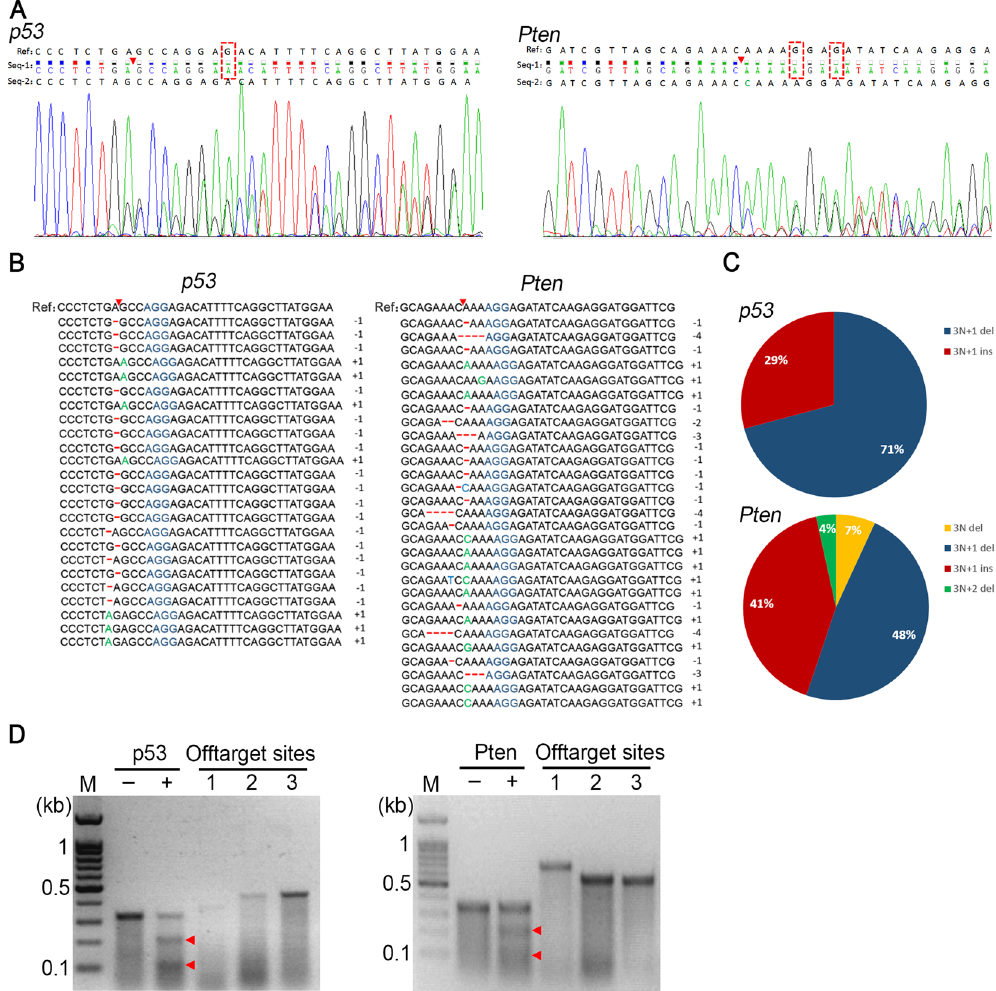
Figure 5. Mutational analysis of individual tumors of C57-HBV mice injected with dual sgRNA cassette. ( A ) Representative p53 and Pten mutations found in the predicted cut sites in tumors. The reference sequences were mouse genomic sequences from the National Center for Biotechnology Information (NCBI; p53 , genebank ID:372099099; Pten , genebank ID:372099091). Seq-1 and Seq-2 represent read sequences obtained from sequencing chromatograms. Different bases between Ref and Seq-1 were revealed with red dashed rectangles. Red triangles indicate the predicted cleavage sites. ( B ) Sequence analysis near the predicted cleavage sites of p53 and Pten in the tumors. A total of forty tumor nodules were examined and only the mutant sequences of p53 or Pten were shown. Red triangles, predicted cleavage sites; Blue bases, the PAM motif; Red lines, deletion; Green bases, insertion; Bases in light blue, mutation. ( C ) Indel mutation profile of p53 and Pten in the tumors. Distribution of indel frame phase was calculated as the length of modulus 3. ( D ) Off-target assessment using the T7E1 nuclease. The p53 and Pten top ranking off-target sites 1, 2, 3 were investigated. − , negative control; + , positive control. Red triangles indicate the bands cut by the T7E1 nuclease. M,